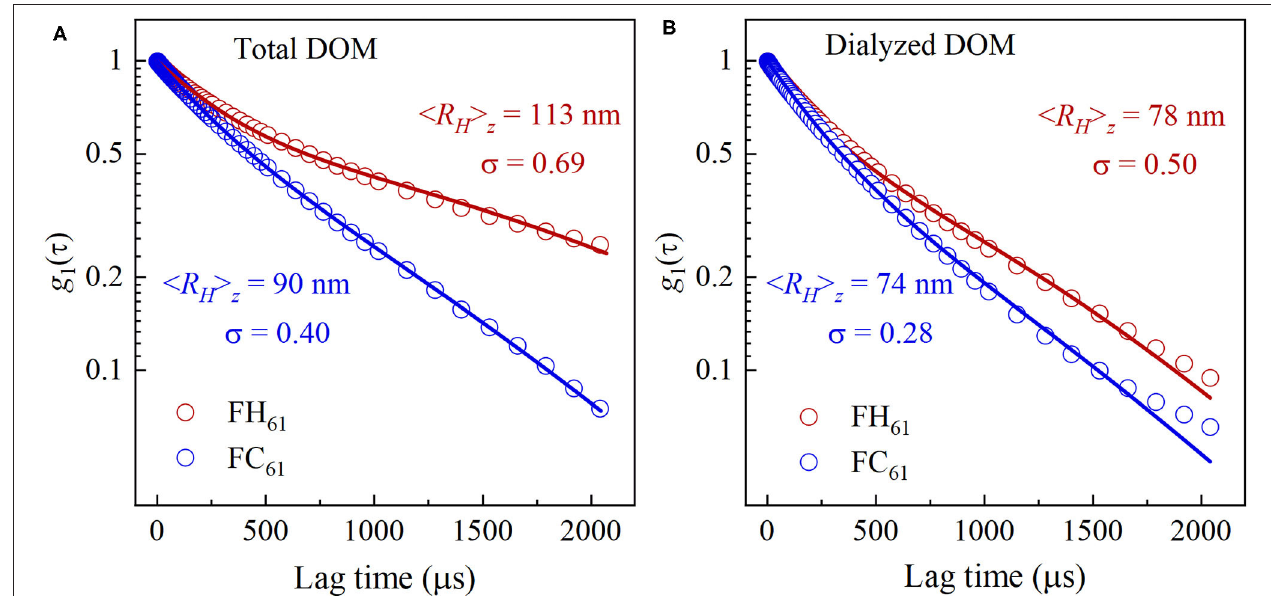
FIGURE 4 | Scattered field correlation functions, g 1 ( τ ) obtained by DLS measurements of FH 61 (red circles) and FC 61 (blue circles) and the corresponding cumulant fits to the data (solid lines) of (A) total and (B) dialyzed DOM. < R H > z is the average hydrodynamic size of DOM and σ is the polydispersity